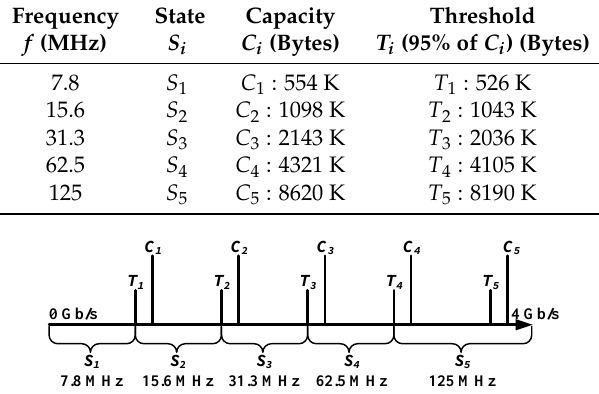
Figure 4. Thresholds of the single threshold policy.